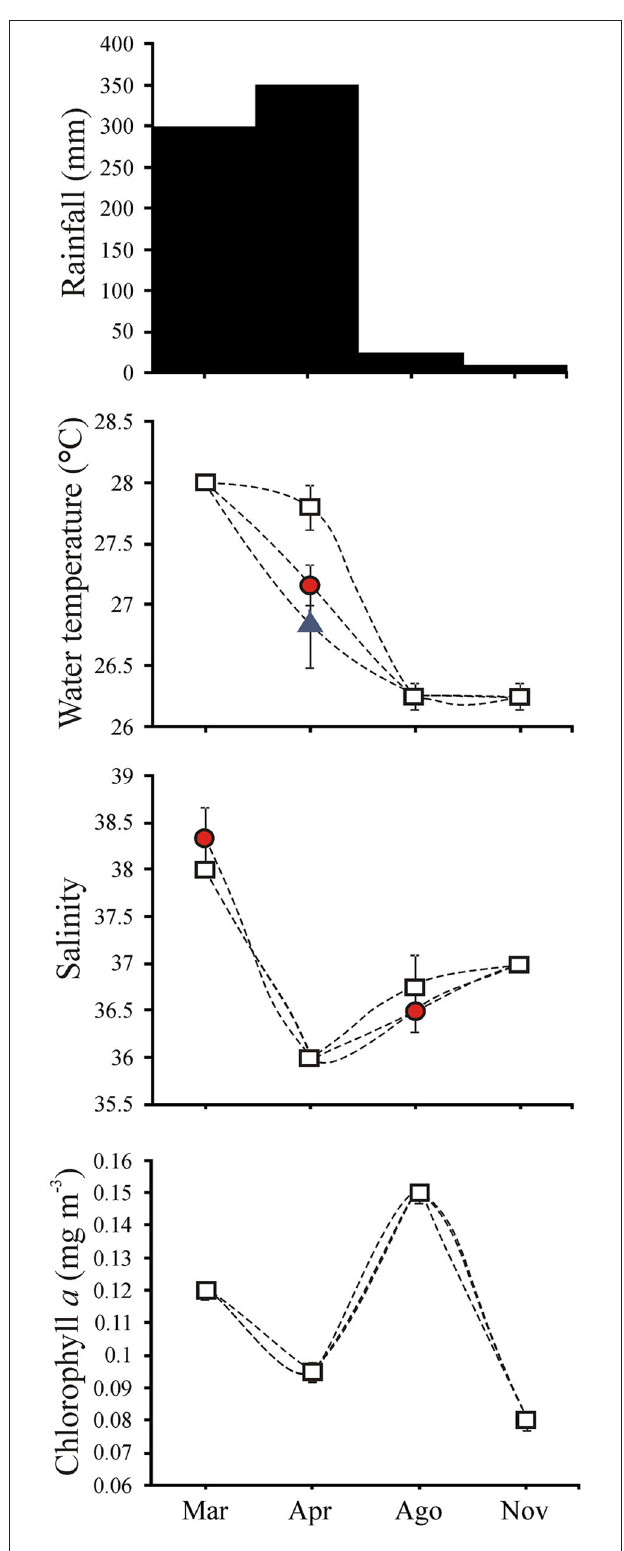
FIGURE 2 | Monthly total rainfall and water temperature ( ◦ C), salinity and chlorophyll a (mg m − 3 ) means ( + S.E.) at D1, < 100m ( ), D2, > 100–500m ( ), and D3, > 500–1500m (